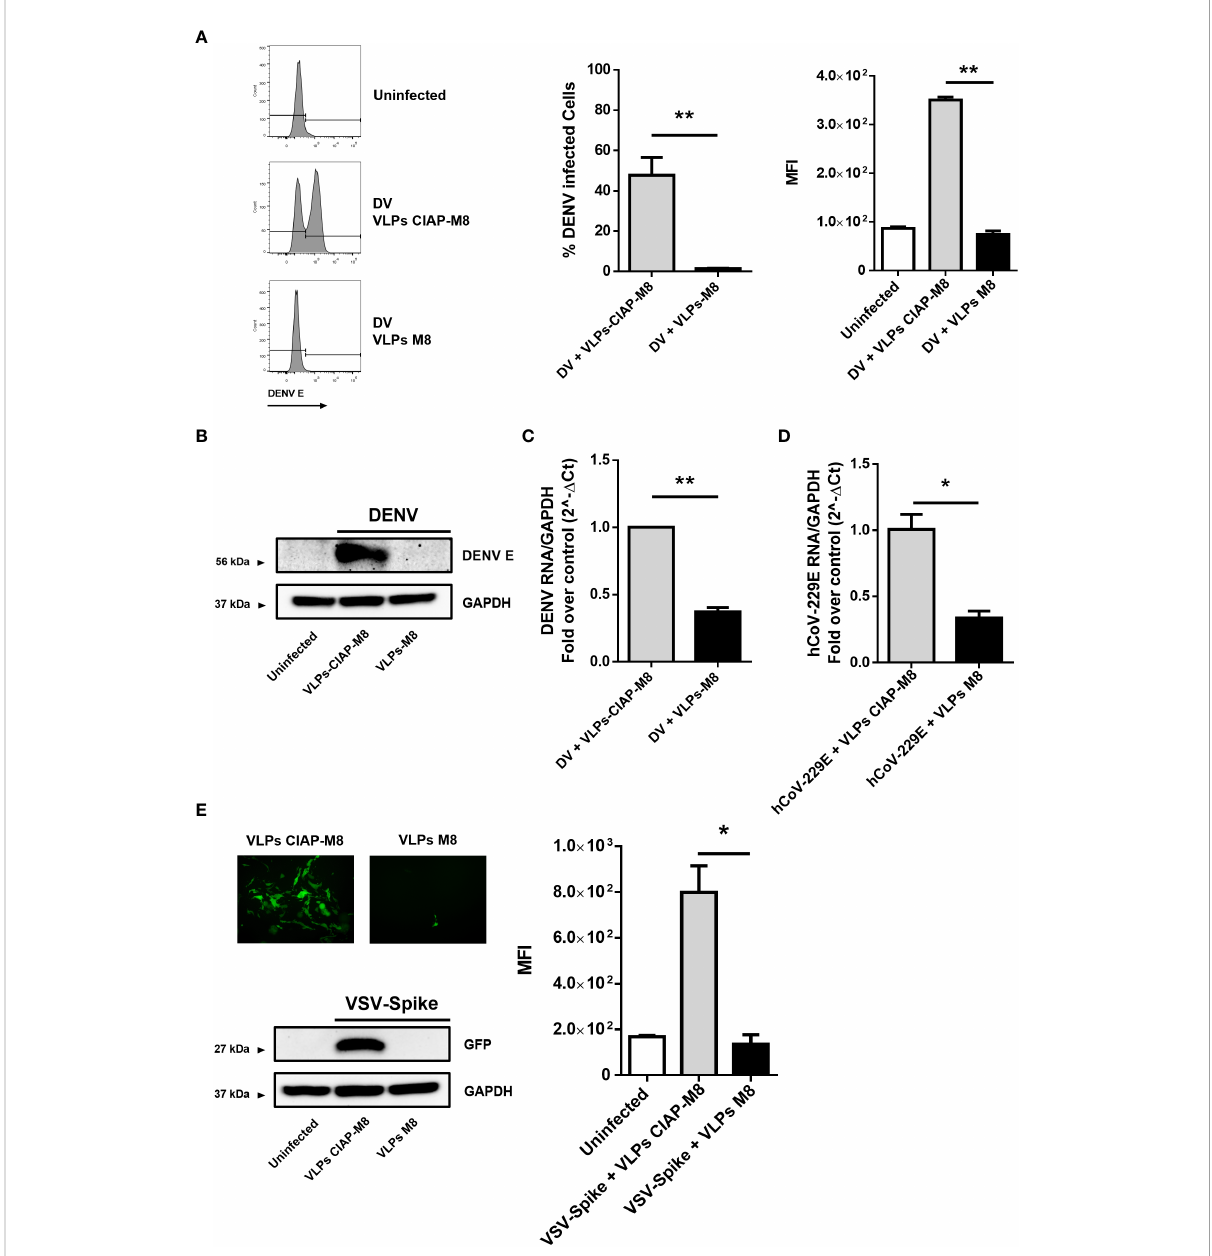
FIGURE 4 VLPs-M8 target different cells and restrict a broad range of viral infections (A) Analysis of DENV infection in A549 cells. Left, representative histograms of DENV E protein expression in infected A549 cells in presence of VLPs-CIAP-M8 or VLPs-M8 determined by fl ow cytometry using a mouse IgG2a mAb, speci fi c for DENV E protein (clone 4G2); central and right panels show percentage of GFP + cells and Mean Fluorescence Intensity, respectively. (B) Immunoblot analysis representative of DENV E protein expression in A549 whole cell extract. Cells were treated with VLPs as indicated for 48h and infected with DENV (MOI 2) for 24h; protein expression was normalized on GAPDH. (C) DENV NS4A RNA expression levels were evaluated by qPCR analysis in A549 cells after 24h of infection. Gene expression was normalized to GAPDH expression and is presented as RNA levels relative to those in VLPs-CIAP-M8 treated cells, set by default at 1. (D) hCoV-229E RNA expression levels were evaluated by qPCR analysis in Huh-7 cells after 24h of infection. Gene expression was normalized to GAPDH expression and is presented as RNA levels relative to VLPs-CIAP-M8 treated cells, set by default at 1. (E) Fluorescence microscopy images obtained using a Olympus fl uorescence microscope (10x magni fi cation) representative of Calu-3 cells treated with VLPs-CIAP-M8 or VLPs-M8 and infected with Spike- VSV-GFP (MOI 0.1) for 72h. Bottom panel shows the immunoblot analysis representative of GFP protein expression in Calu-3 whole cell extract. Cells were treated with VLPs as indicated for 48h and infected with Spike-VSV-GFP (MOI 0.1) for 72h; protein expression was normalized on GAPDH. Right panel, Mean Fluorescence Intensity (MFI) of GFP measured by fl ow cytometry. Data represent mean+SEM from 3 independent experiments. Statistical signi fi cance was de fi ned as follows: *p < 0.05,